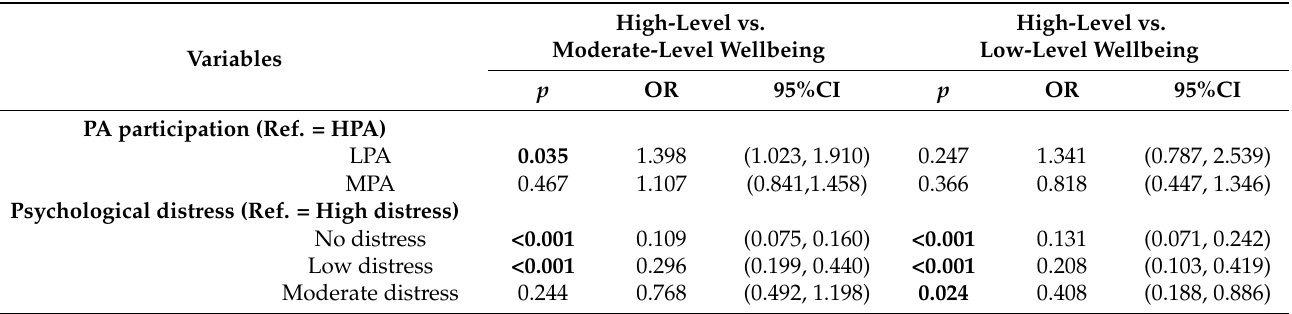
Figure 1. Standardized mean symptom scores by latent classes of wellbeing. Table 4. Multinomial logistic regression analysis of levels of PA participation and psychological distress on latent classes (n =